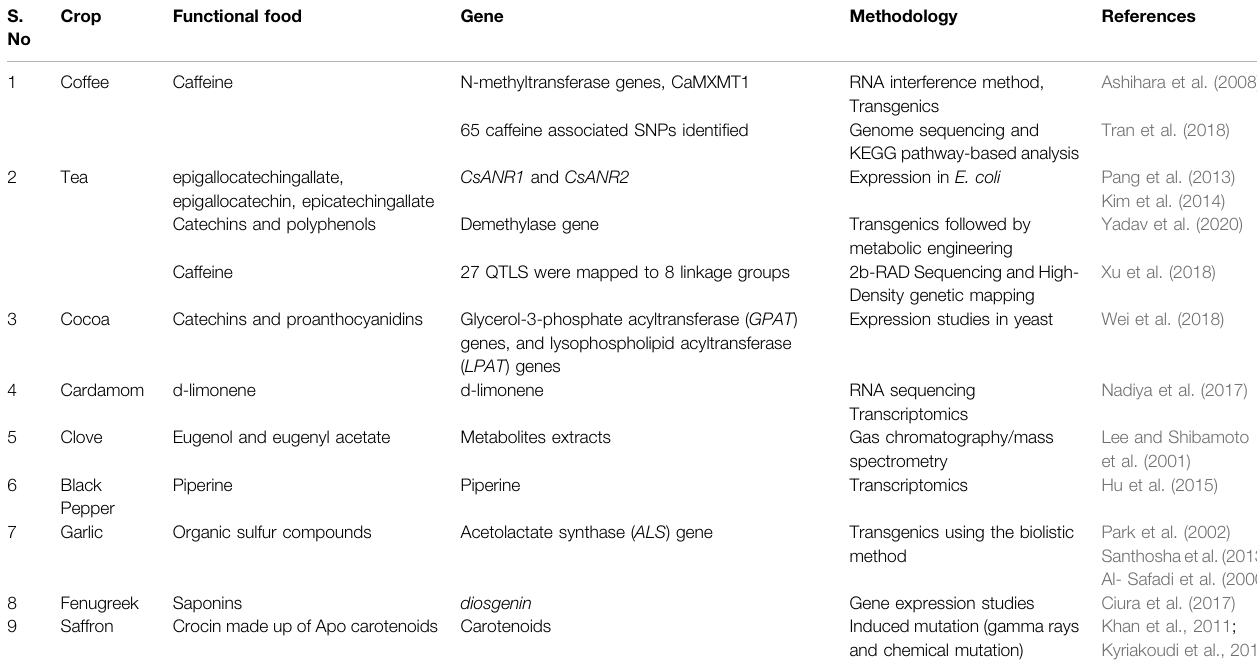
TABLE 5 | Study of functional foods in beverages, spices and condiments using biotechnological approaches. S.